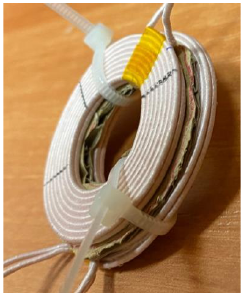
Figure 2. Air transformer under test.